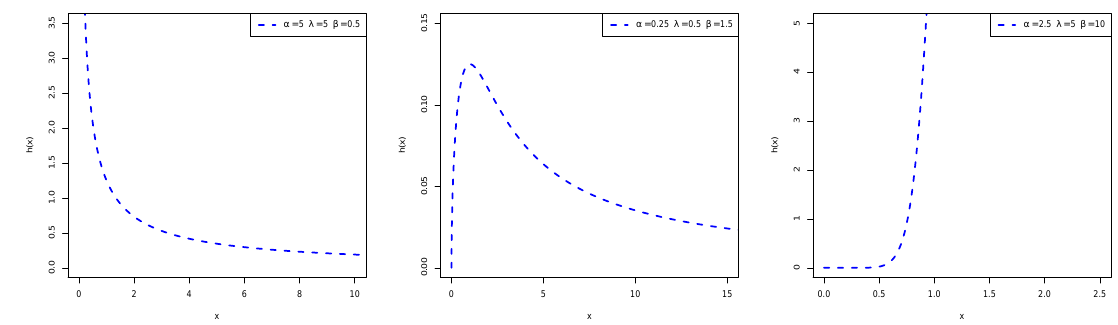
Figure 2. Possible shapes of the Ex-LL hazard function for various values of α , β and λ